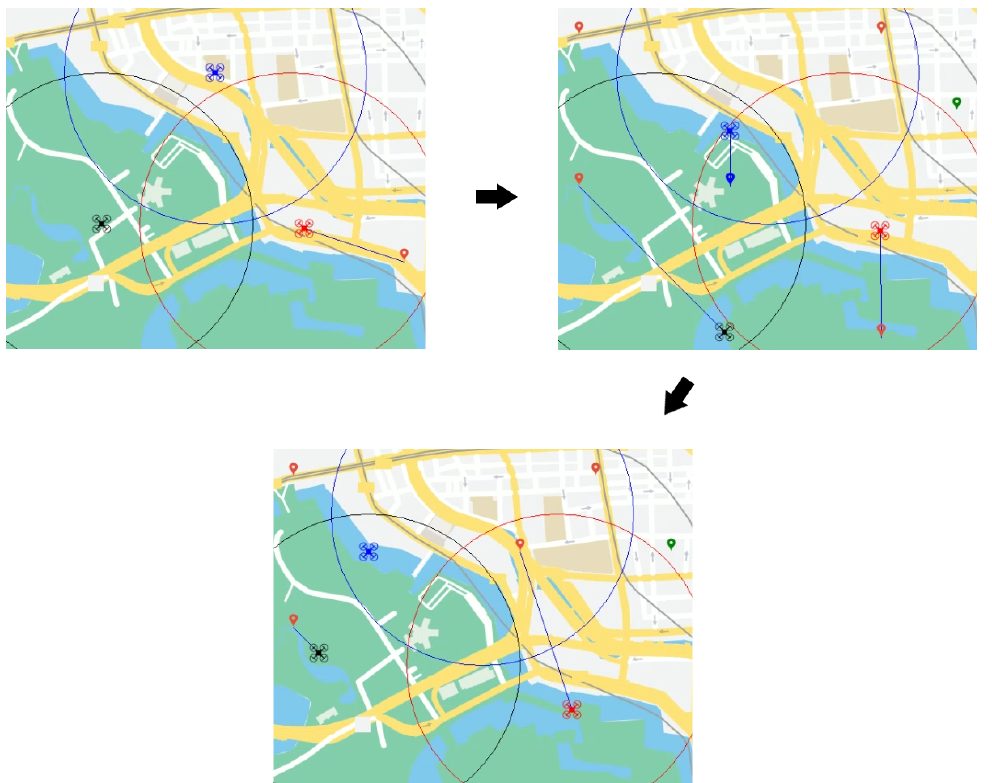
Figure 4. Drone team allocation problem as Dynamic